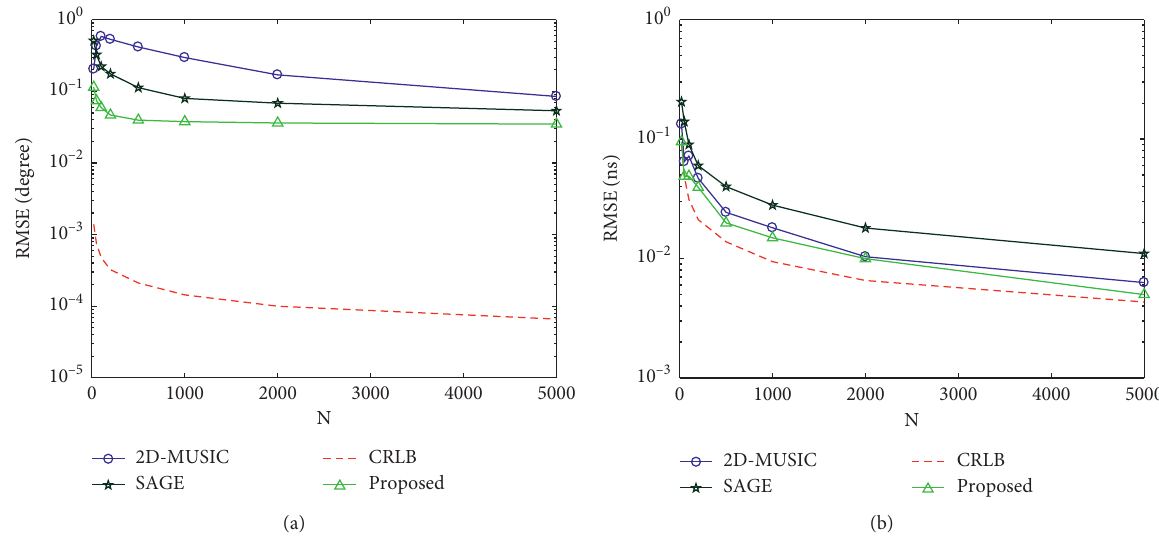
Figure 6: Performance comparison regarding time intervals when signals are coherent. (a) DOA and (b) time delay.